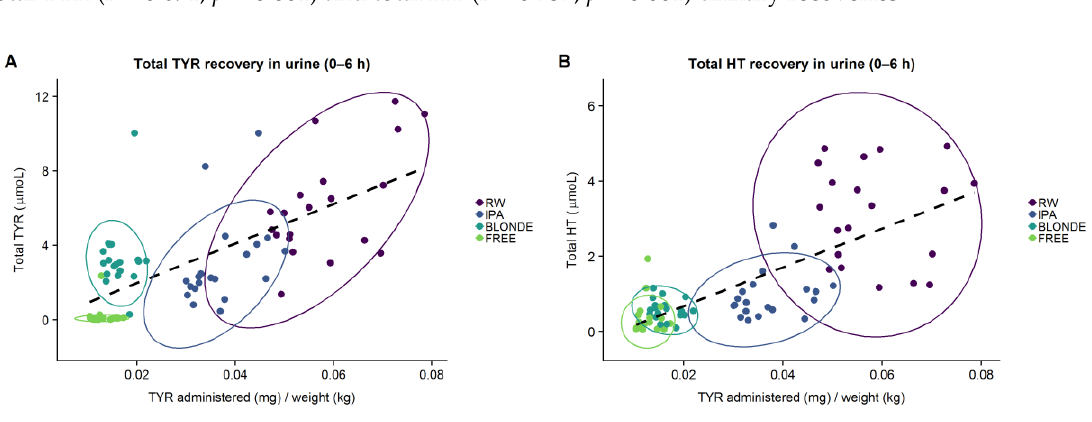
Figure 1. Correlation between tyrosol (TYR) administered adjusted by body weight and total TYR 6